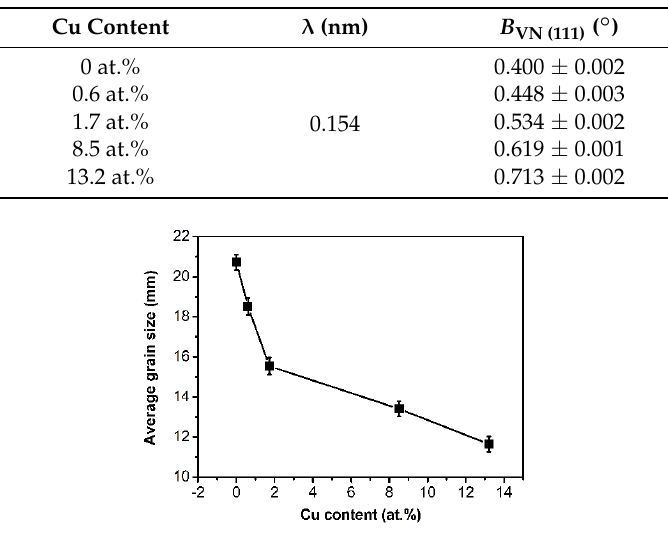
Figure 5. Grain sizes of VCN–Cu composite films with different Cu contents.